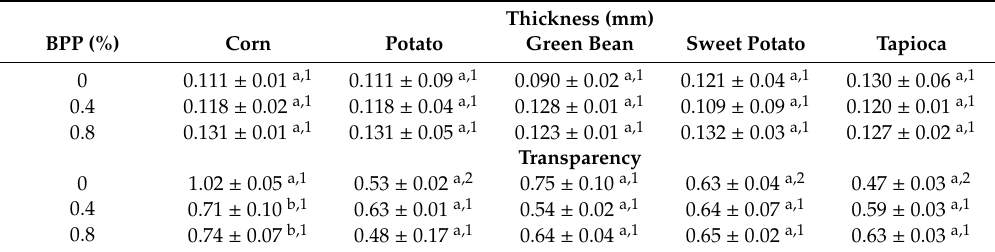
Table 2. The thickness and transparency value of films made from di ff erent types of starch with di ff erent starch and BPP levels. Data points represent the means ± standard deviations of three